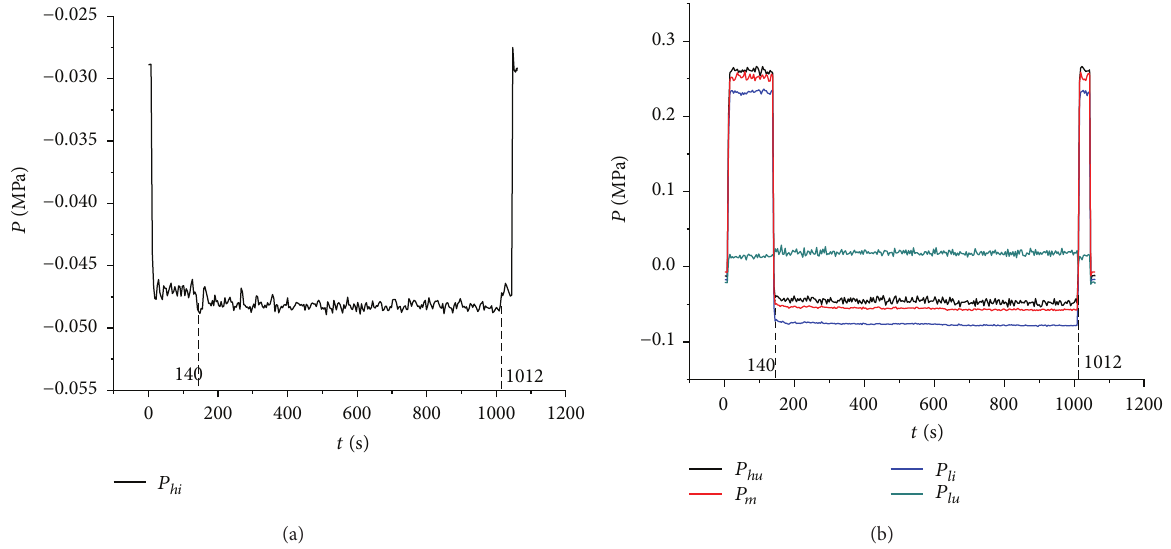
Figure 5: Variation trend of 𝑃 ℎ𝑖 , 𝑃 ℎ𝑢 , 𝑃 𝑚 , 𝑃 𝑙𝑖 , and 𝑃 𝑙𝑢 in experiment I. 𝑃 ℎ𝑖 —suction pressure of sliding vane pump, 𝑃 ℎ𝑢 —discharge pressure of sliding vane pump, 𝑃 𝑚 —pressure at the interposition of the series pipelines of two pumps, 𝑃 𝑙𝑖 —suction pressure of centrifugal pump, and 𝑃 𝑙𝑢 —discharge pressure of centrifugal